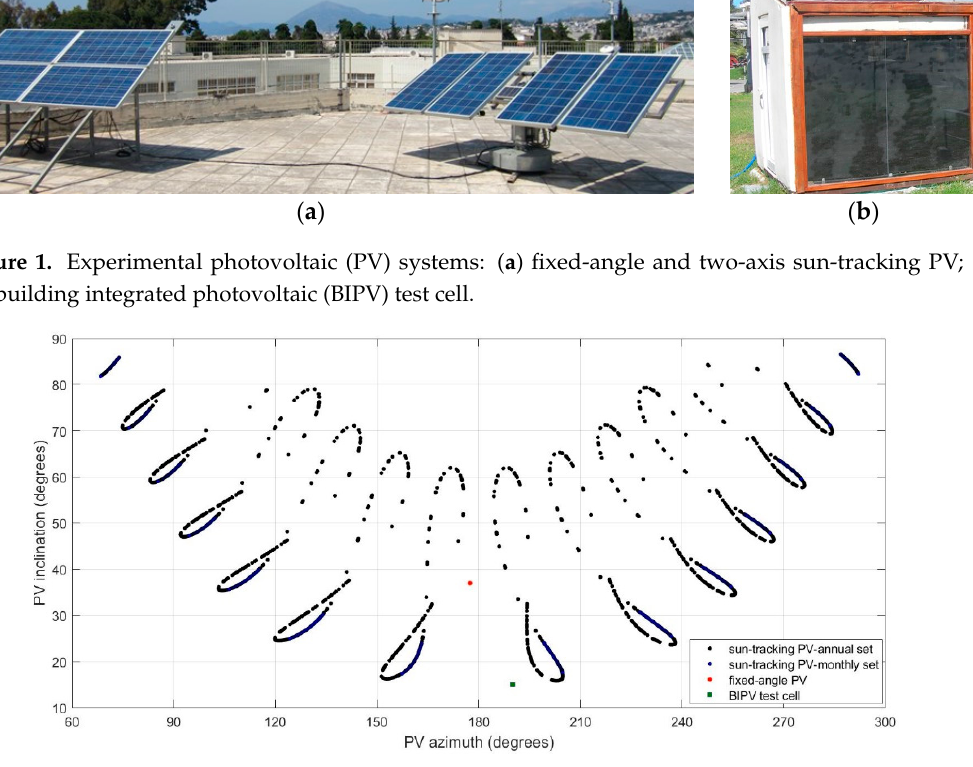
Figure 2. PV inclination and azimuth angles at the test positions of the sun-tracking, fixed-angle PV and BIPV systems.